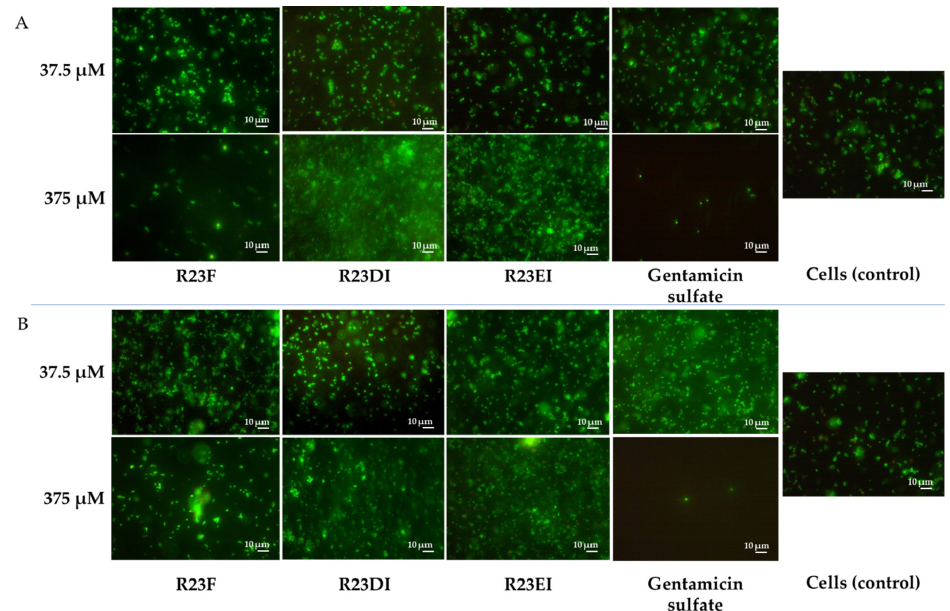
Figure 11. Fluorescence microscopic images of ( A ) MRSA (SA 180-F strain) and ( B ) S. aureus (129B strain) cells treated with peptides R23F, R23DI, and R23EI. The shape of the cells is not changed after co-incubation with peptide R23F, however, the amount of cells in the field of view in the sample with a concentration of 375 μ M is lower than in the sample with a concentration of 37.5 μ M in both strains. When cells were tected during microscopy of samples with peptide concentrations of 37.5 μ M and 375 μ M.